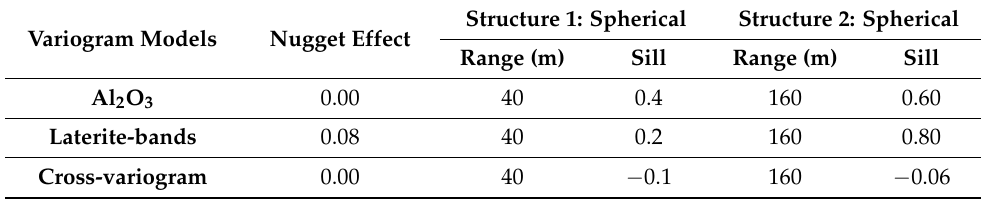
Table 5. Direct and cross-variogram models between Al 2 O 3 and laterite band ratio (data from June–July